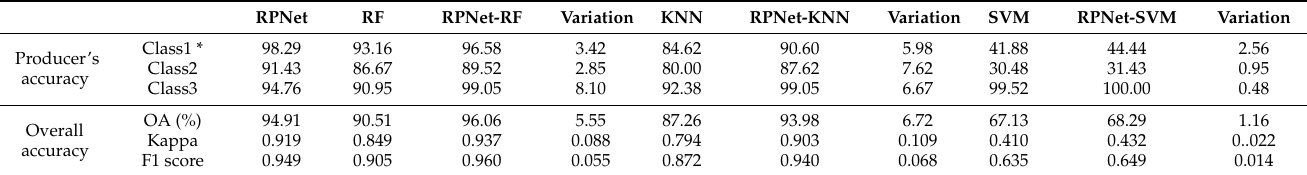
Table 6. Comparison of accuracies of traditional methods and decision fusion methods (S2).